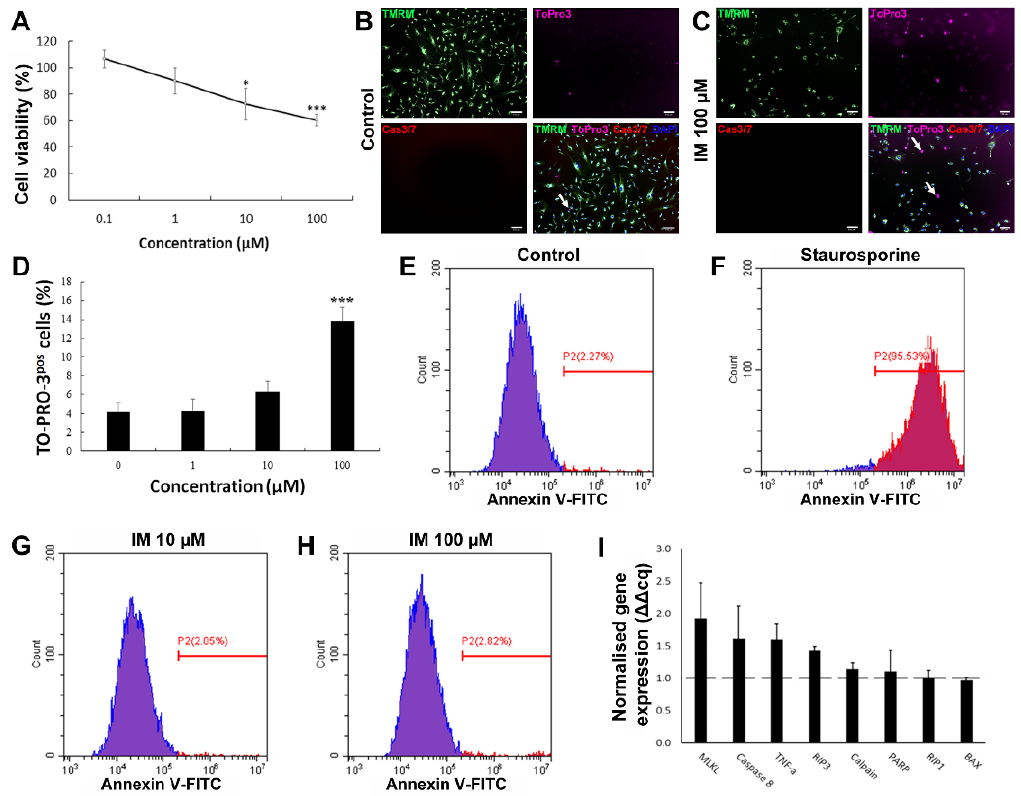
Figure 1. IM reduces hCPC viability but does not induce apoptosis. ( A ) Cell viability as percentage of untreated control, IM treatment range: 0.1–100 µM, n = 5. ( B , C ) Representative images of live cell staining with mitochondrial marker TMRM and nuclear marker DAPI, with ToPro-3 (arrows indi- cating selected dead cells) and caspase 3 and 7 substrate; IM application caused no caspase activity.